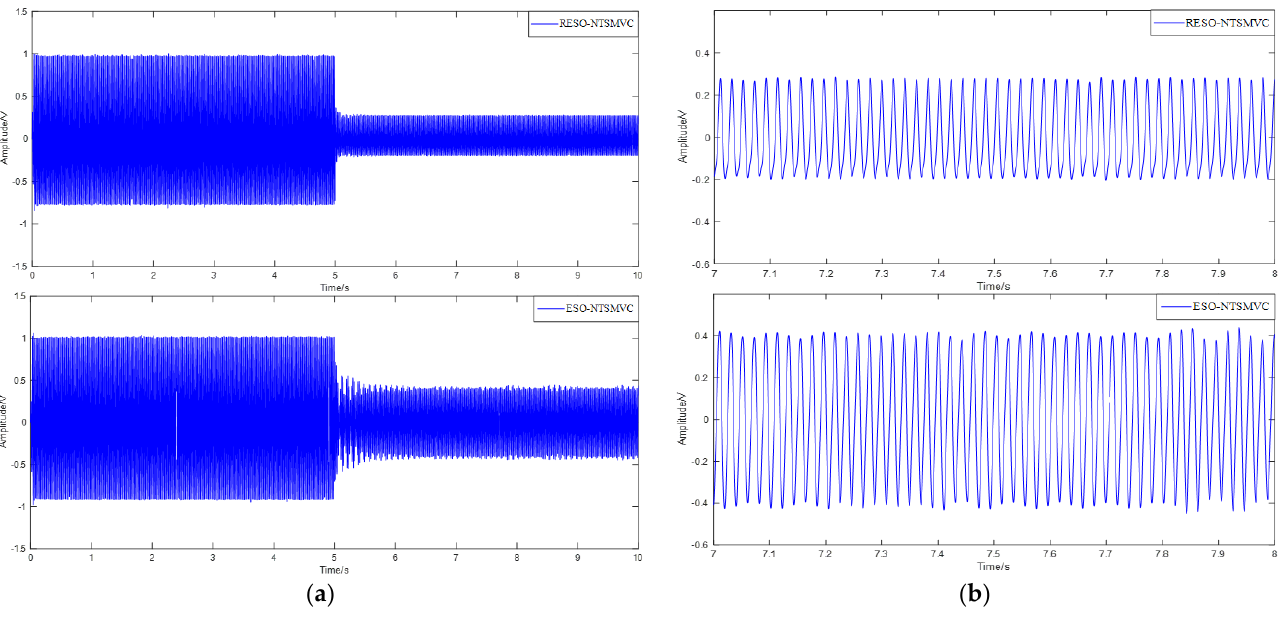
Figure 5. Experimental results of time domain response: ( a ) global time domain response curve; ( b ) local time domain response curve.